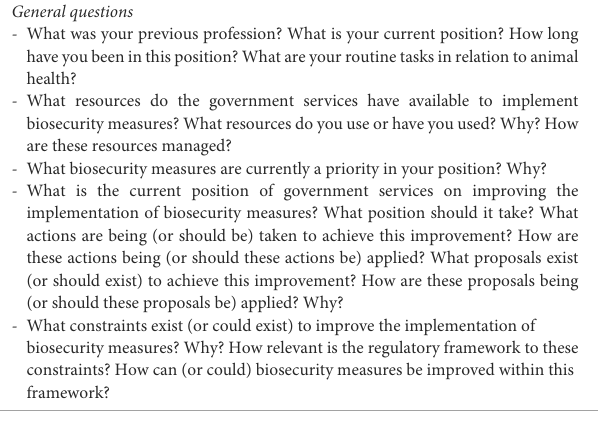
TABLE 2 Codes and meaning units in content